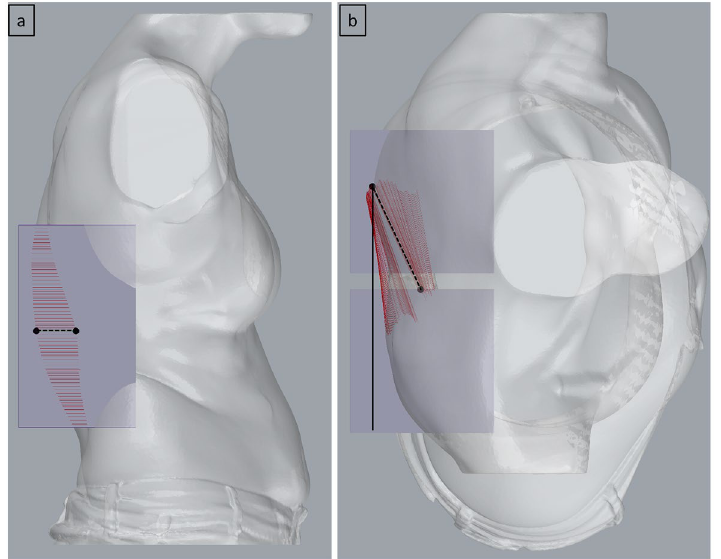
Fig 5. Torso rotation angle measurement ( a ) right view ( b ) top